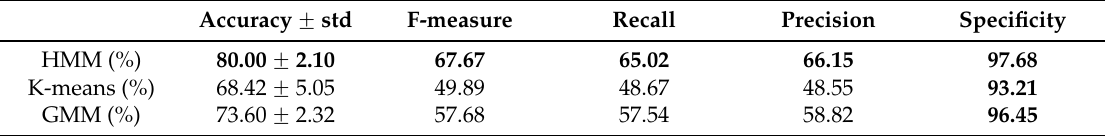
Table 4. Performance results of the unsupervised algorithms using raw